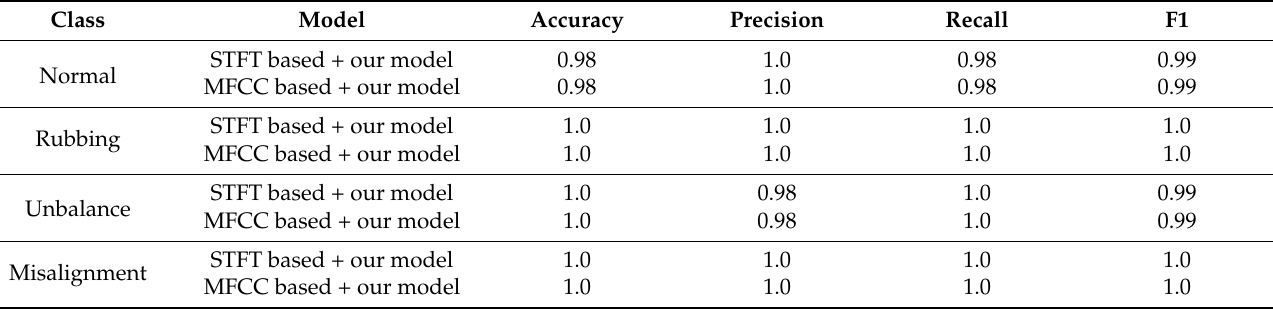
Table 3. Experimental